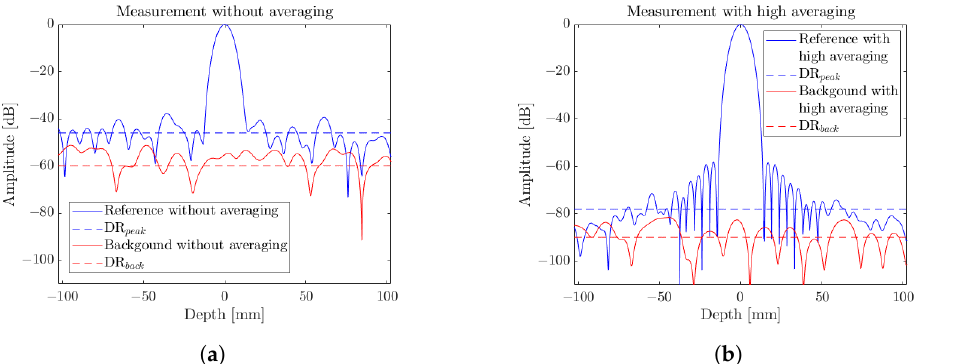
Figure 5. FMCW radar amplitudes spectrum for normalized references and background measure- ments ( a ) when no averaging is considered for high-cadence measurements, and ( b ) at high averaging levels, for high-dynamic-range sensing equivalent to a 1 min equivalent integration